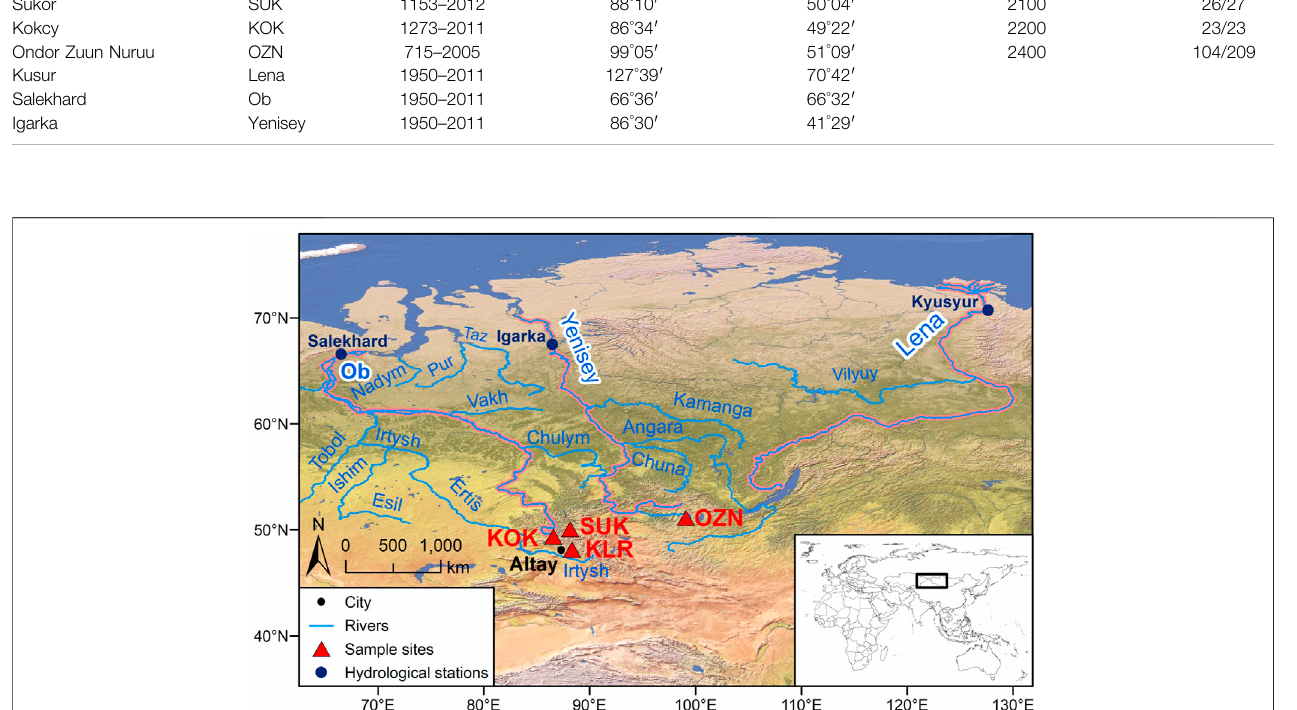
FIGURE 1 | Map of study area showing the locations of the main rivers (Yenisei, Lena and Ob) in norther Asia and the locations of the four tree-ring sampling sites (KLR, KOK, SUK, and OZN). See text for additional details.